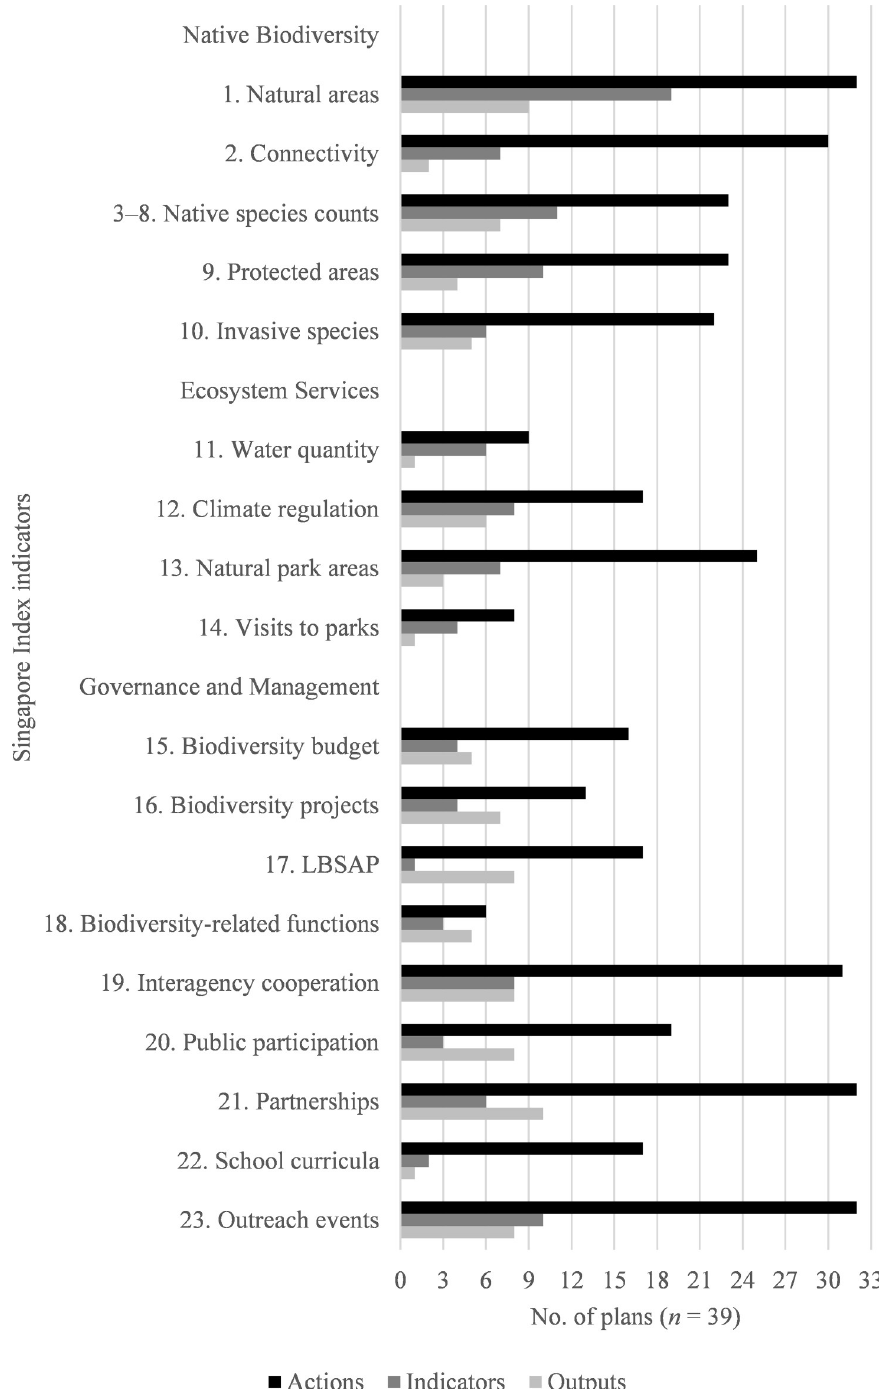
Fig 3. Plan elements by Singapore Index indicator. This chart compares the classification of plan elements (actions, indicators or outputs) from all 39 sampled cities according to the 23 SI indicators (indicators 3 to 8 were treated together for classification purposes) under the core components of native biodiversity (NB), ecosystem services (ES), and governance and management (GM). Note that while the majority of the plans included some actions related to most of the SI indicators, far fewer plans attempted to measure progress or outcomes using indicators or